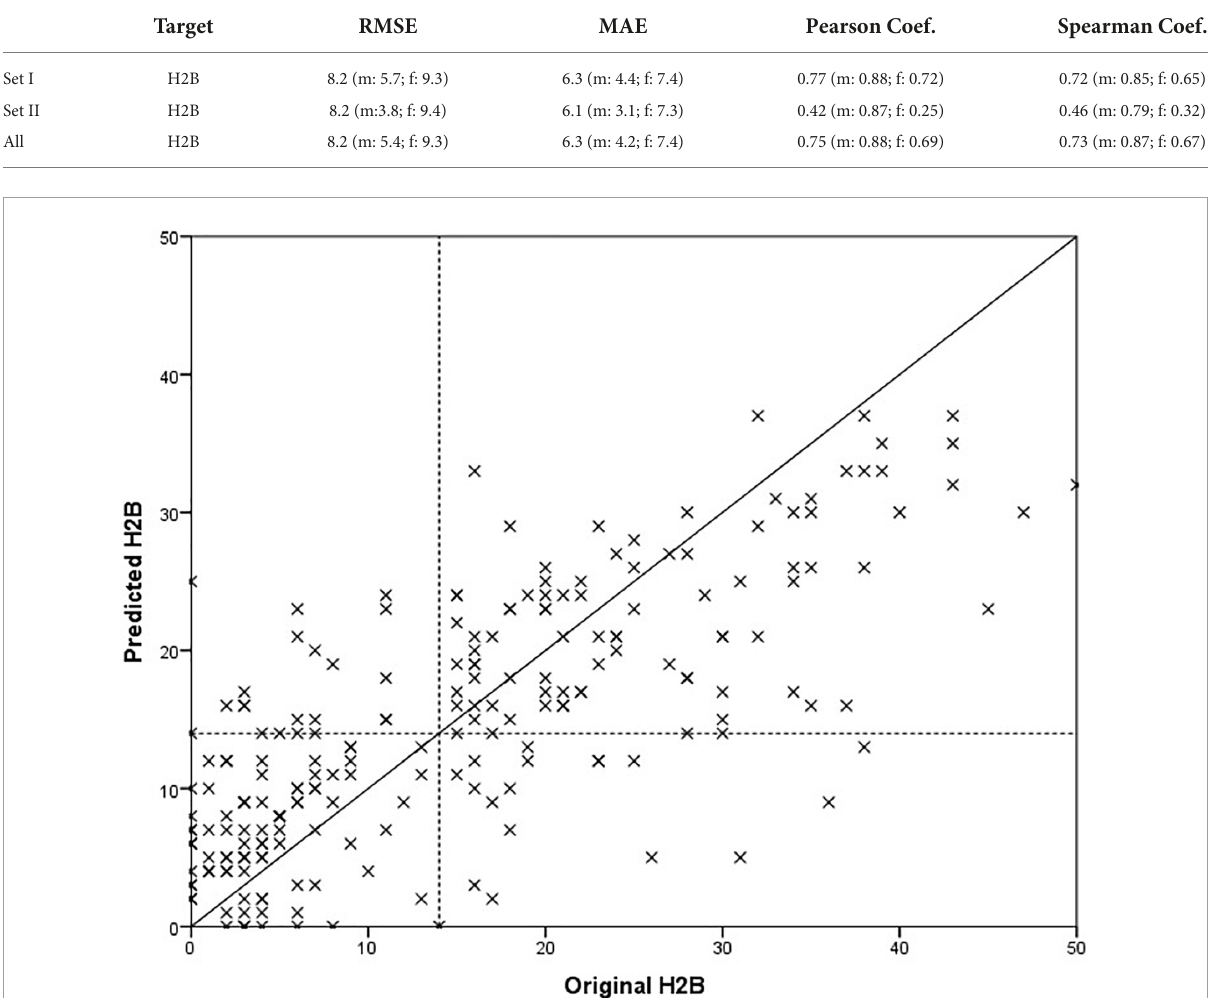
FIGURE4 Comparison of predicted and original depression severity scores, when the H2B scores were used for training.